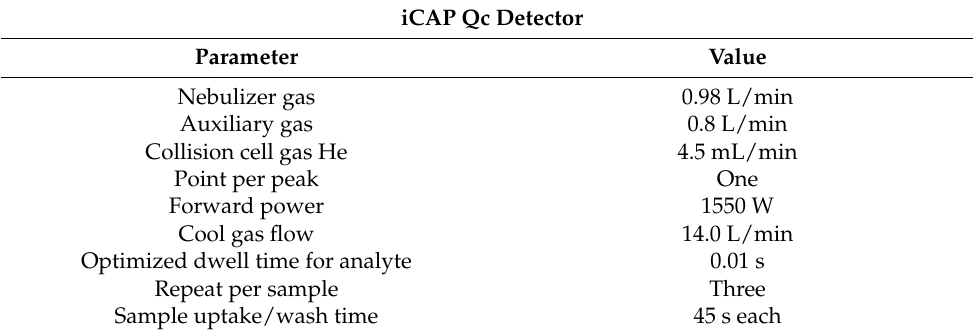
Table 2. The iCAP Qc ICP-MS operating